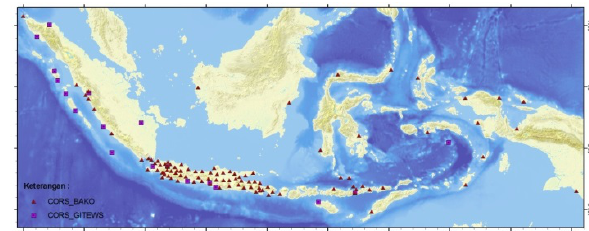
Figure 3. Continuously Operating Reference Stations (CORS) of Indonesia (courtesy of BIG)